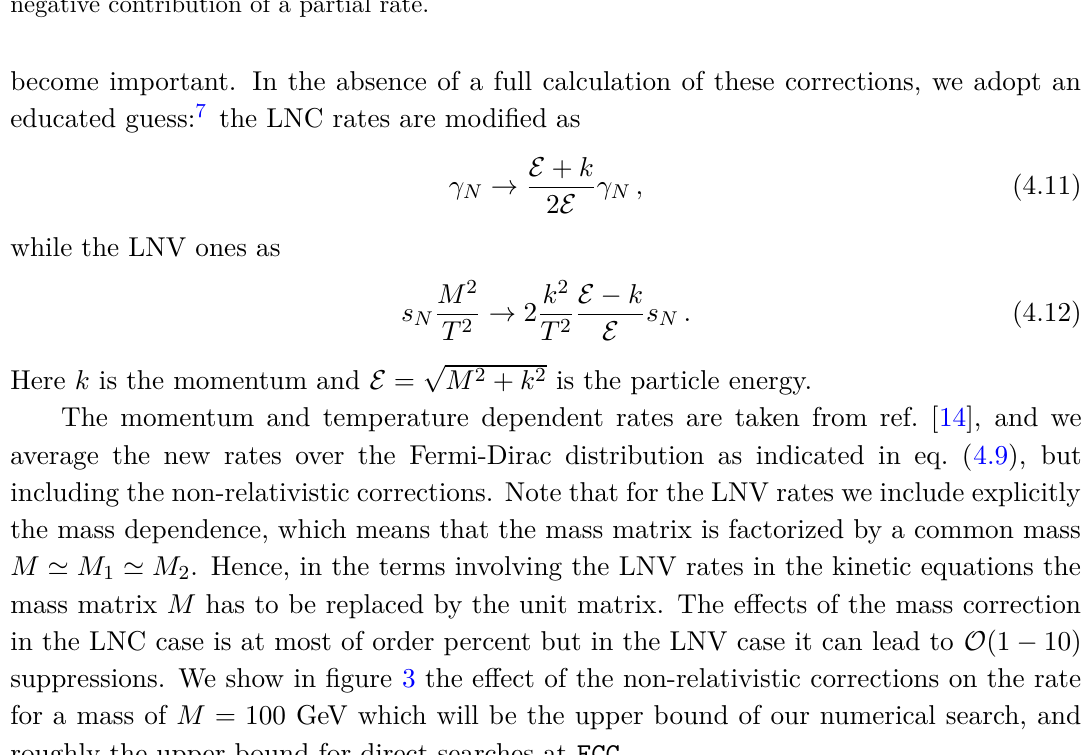
i /T and h s ( n ) i /T . A dashed line indicates a N N